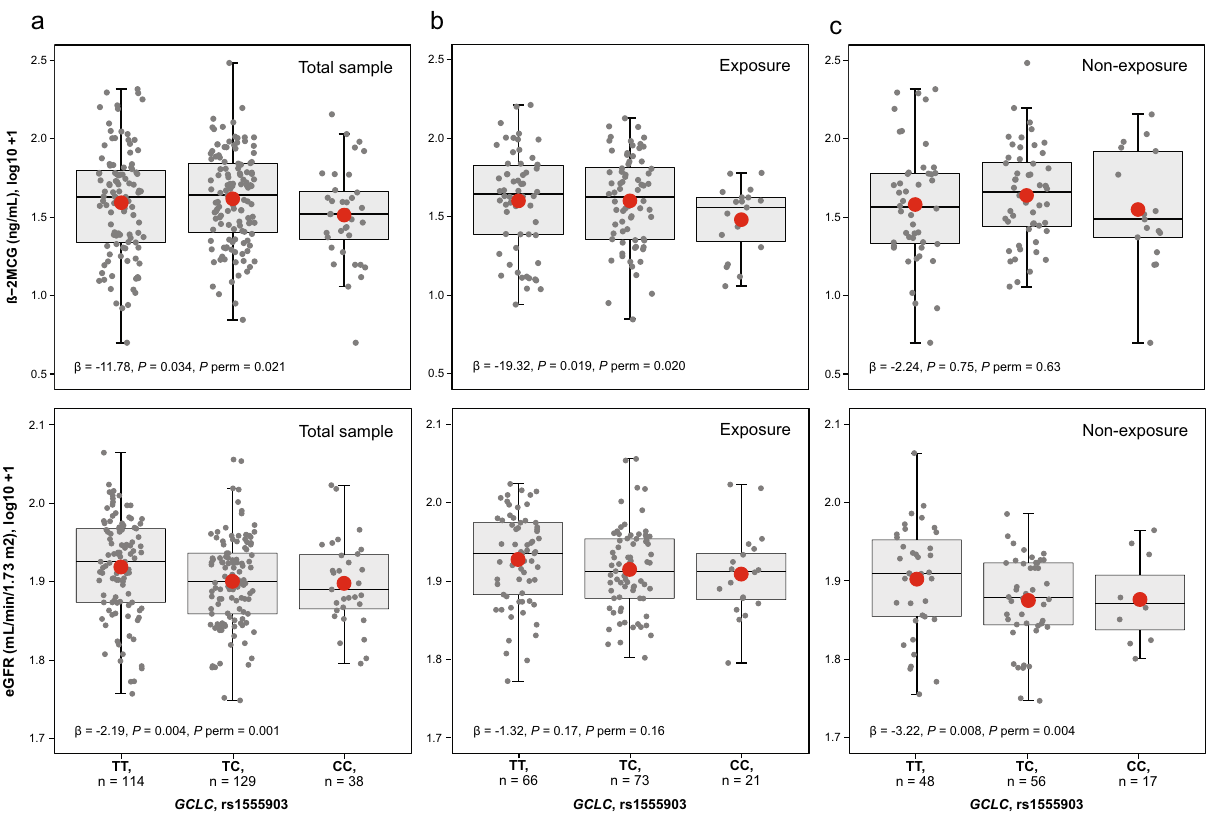
Figure 1. Beta-2-microglobulin (β-2MCG) and estimated glomerular filtration rate (eGFR) in relation to GCLC rs1555903 genotypes. The boxplot shows a significantly decreasing trend of both β-2MCG and eGFR in the total sample (a, P < 0.05). Analysis by exposure status also shows a similar trend in the exposure group with β-2MCG ( b, β = − 19.32, P = 0.019, P perm = 0.020) and in the non-exposure group with eGFR ( c , β = − 3.22, P = 0.008, P perm = 0.004). Each SNP was examined using multivariable linear regression models assuming additive model of inheritance adjusted by age, sex, blood-Hg levels (µg Hg/L), urine-Hg levels (µg Hg/g creatinine), hair-Hg levels (µg Hg/g hair), and duration of exposure